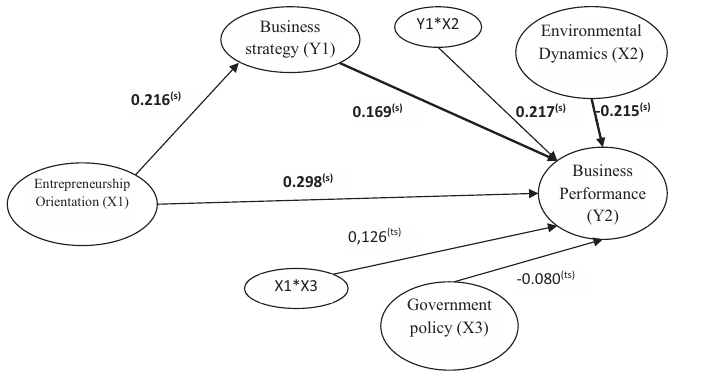
Figure 2. Path diagram of hypothesis testing